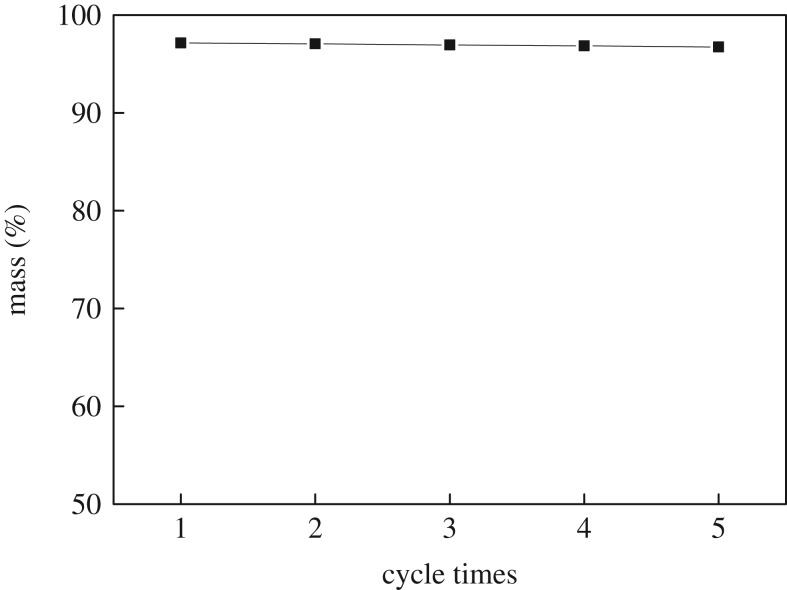
Reuse performance of the immobilized IL [C3SO3Hnmp]HSO4.